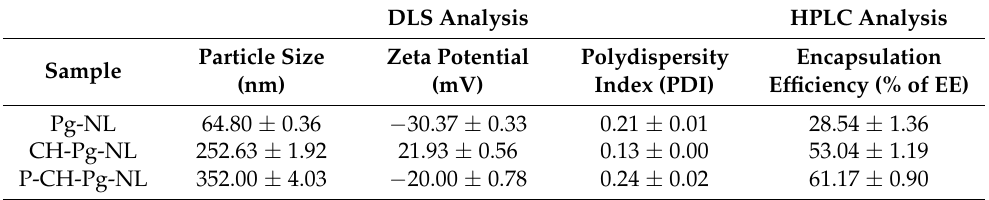
Table 1. Characterization of Pg-loaded different nanoliposomal systems using the DLS and HPLC analysis.